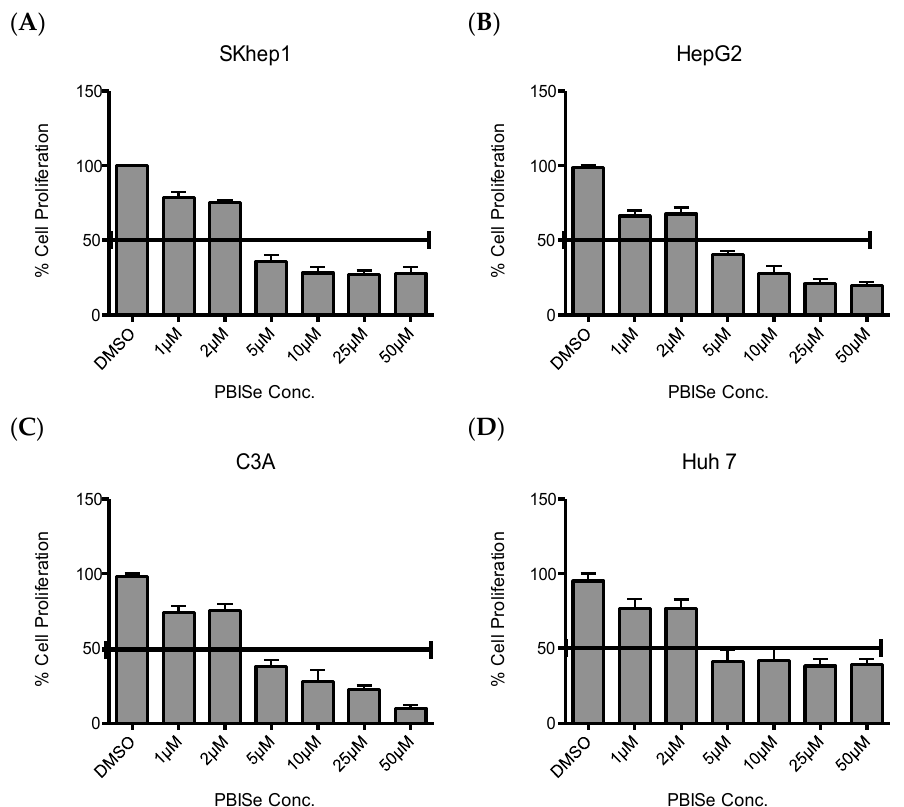
Figure 1. PBISe treatment inhibits the growth of HCC in vitro. Four different HCC cells lines were used to demonstrate the inhibition process. ( A ) Skhep1; ( B ) HepG2; ( C ) C3A; ( D ) Huh-7. PBISe inhibits proliferation of all HCC cell lines in a dose dependent manner. The HCC cells were seeded onto 96-well plates (5000 per well) in MEM with 10% FBS and allowed to attach overnight. Cells were then treated with PBISe or DMSO at indicated concentrations the following day, as shown in the figure. After 48 h of treatment, cell proliferation assays were performed using Cell’Titer 96 Aqueous Assay Kit (Promega) according to manufacturer’s instructions. Results of three individual experiments were plotted as percentage of cell proliferation. The bars indicate Mean ± S.E.